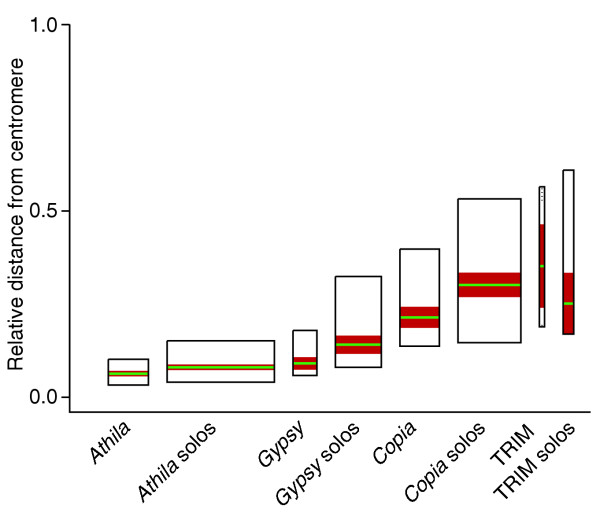
Differential pericentromeric clustering of complete elements and solo-LTRs along the 10 chromosome arms combined. The vertical axis measures distance from the centromere, divided by the length of the chromosome arm in which a given element is inserted: the value of 0.0 corresponds to the position of the centromeres and 1.0 to telomeres. Box heights indicate the inter-quartile range and widths are proportional to sample size; red bands represent 95% confidence limits on the median; and the green stripe marks the median value of each sample. Coordinates for the approximate centers of the centromeres on the chromosome sequences were set at 14.70 Mbp for chromosome I (total length 30.14 Mbp), at 3.70 Mbp for II (19.85 Mbp), at 13.70 Mbp for III (23.76 Mbp), at 3.10 Mbp for IV (17.79 Mbp), and at 11.80 Mbp for V (26.99 Mbp).